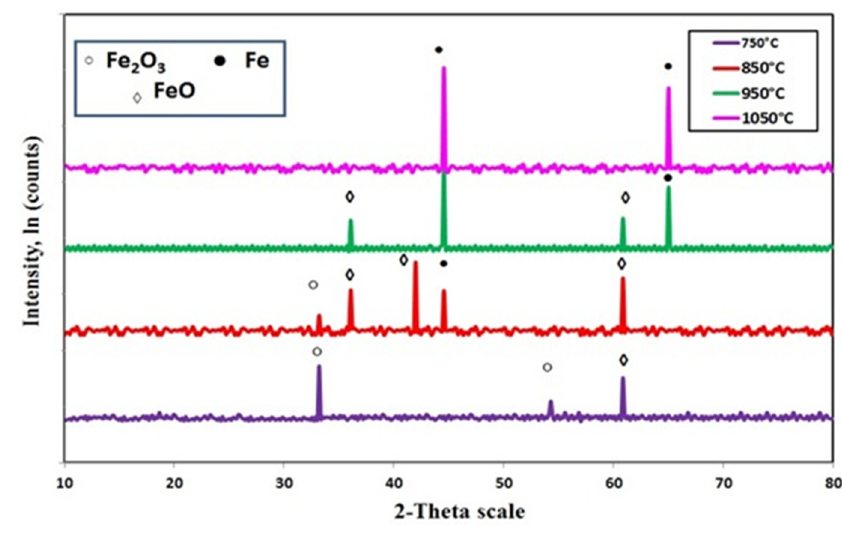
Figure 19. XRD patterns of the samples partially reduced by charcoal.